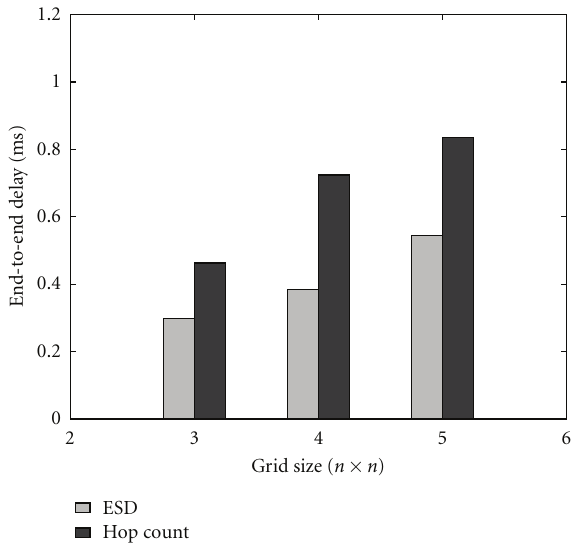
Figure 5: Delay comparison: ESD metric versus hop